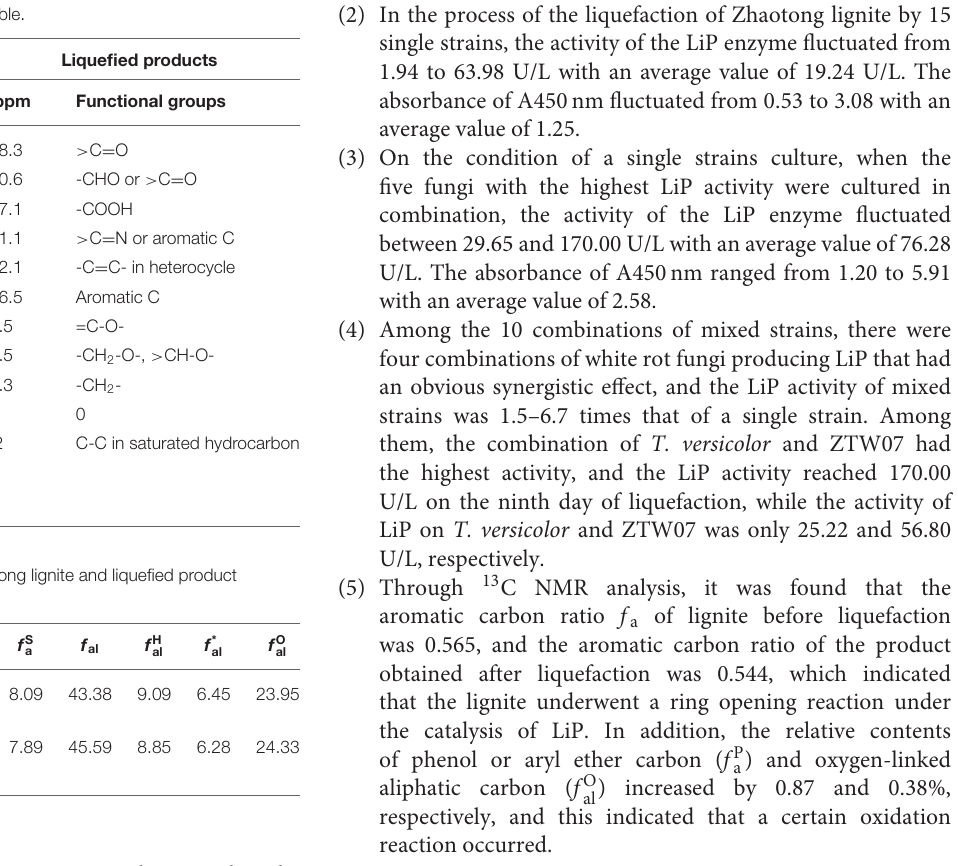
TABLE 2 | 13C NMR peak assignment table.